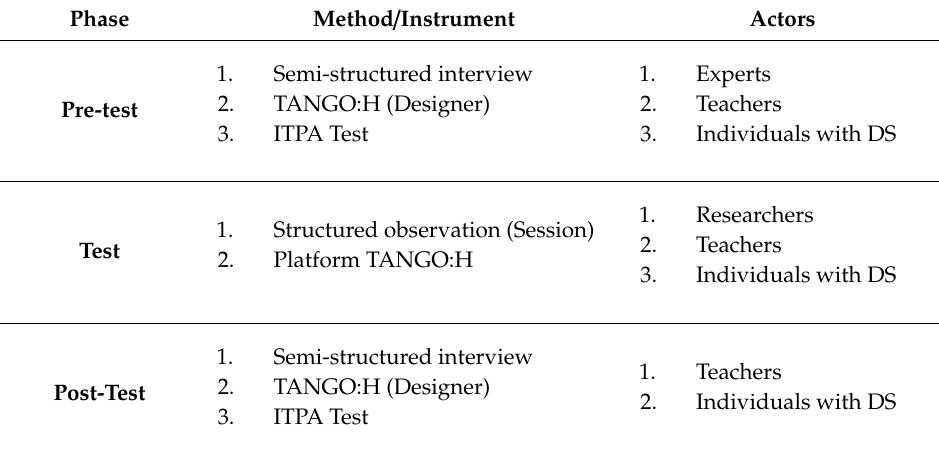
Table 1. Di ff erent phases, methods, and instruments used in the